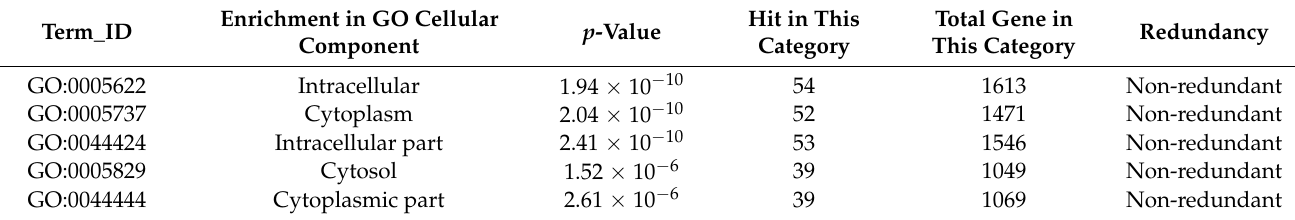
Figure 5. Enrichment in cellular component category of gene ontology (GO) for the protein targets of polyphemusin-I. ( A ) GO cellular component enriched term analyzed by DAVID database with p -value cutoff of ≤ 0.05 for the selection of significant enrichment terms (dotted line represent p -value = 0.05). ( B ) REVIGO analysis for the selection of non-redundant GO term from the list of DAVID generated GO enrichment results in cellular component. Bubble indicated enriched non-redundant GO term and the color (red to pink) represent significant enrichment based on p -value. The highly similar non-redundant GO term showed connection and the width of line represent degree’s similarity. Table 3. Enrichment analysis of protein targets of polyphemusin-I in GO of cellular component category.